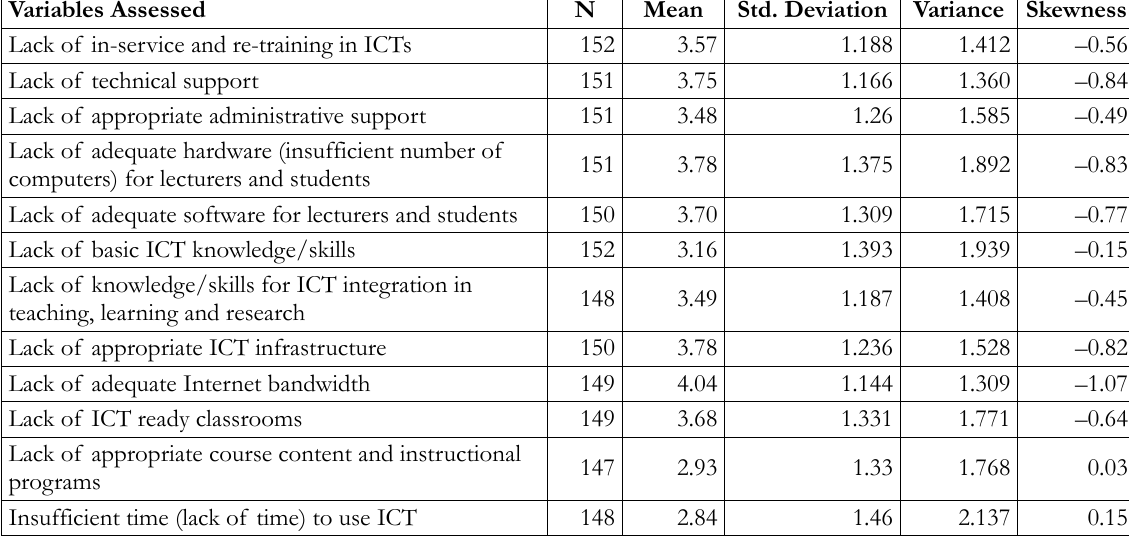
Table 3. Barriers and Obstacles to integrate ICTs in teaching and